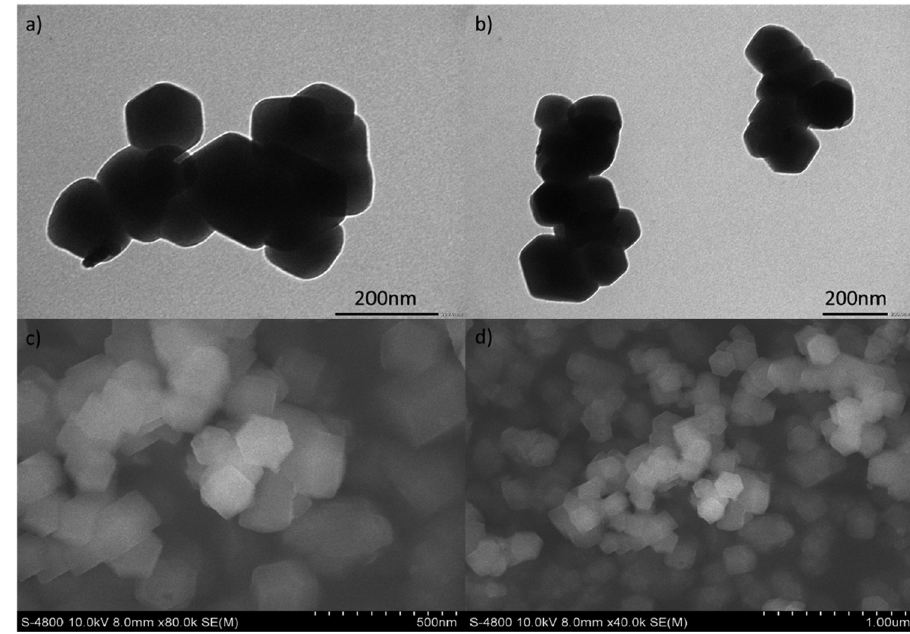
Figure A4: TEM images of CuZn - ZIFs ( a, b: 20,000 ×) and SEM images of CuZn - ZIFs ( c: 80,000 × , d: 40,000 ×)